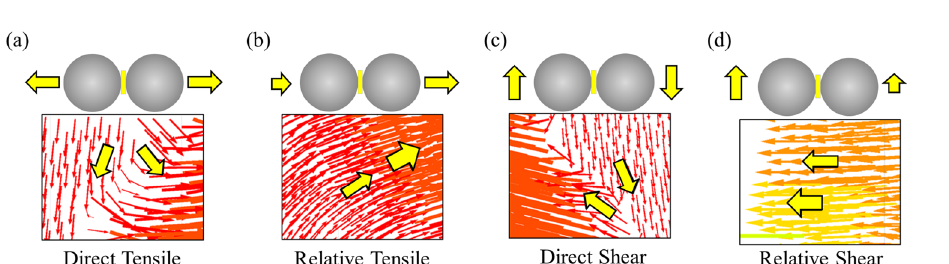
Figure 11. Four displacement modes between particles in PFC 2D .